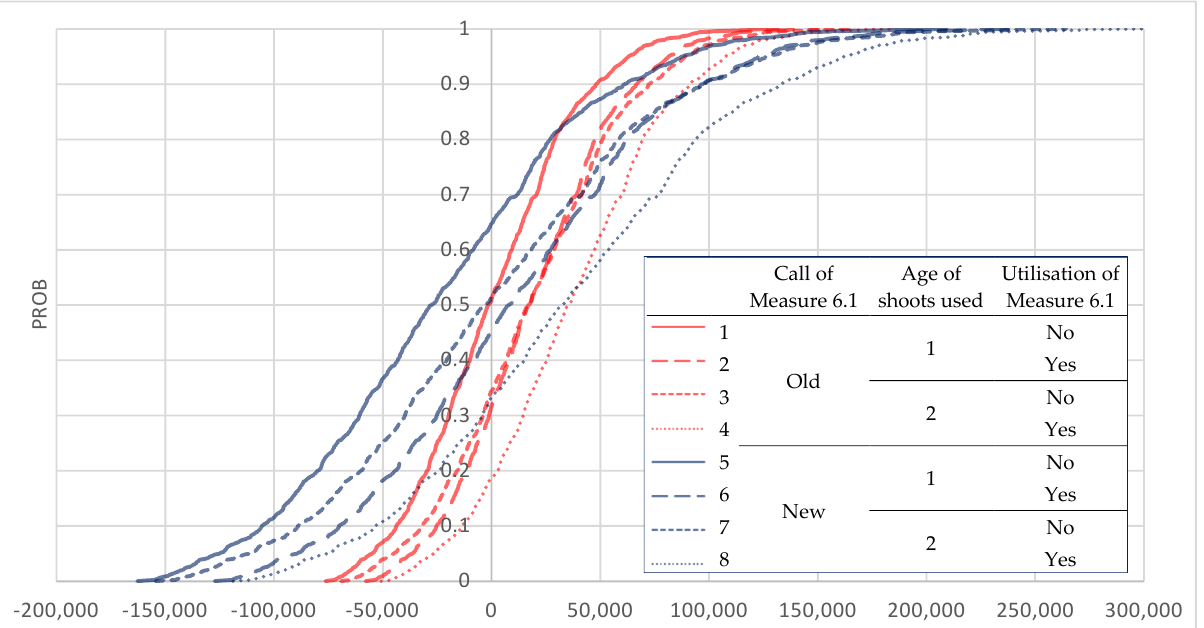
Table 5. Results of the stochastic estimation of the net present value (NPV) per scenario.